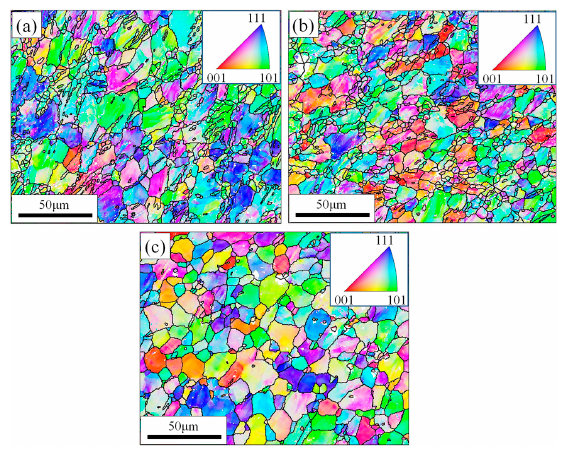
Figure 3. OIM microstructures of the NiTiFe SMA subjected to ECAE at various temperatures: ( a ) 400 °C; ( b ) 450 °C; ( c ) 500 °C.